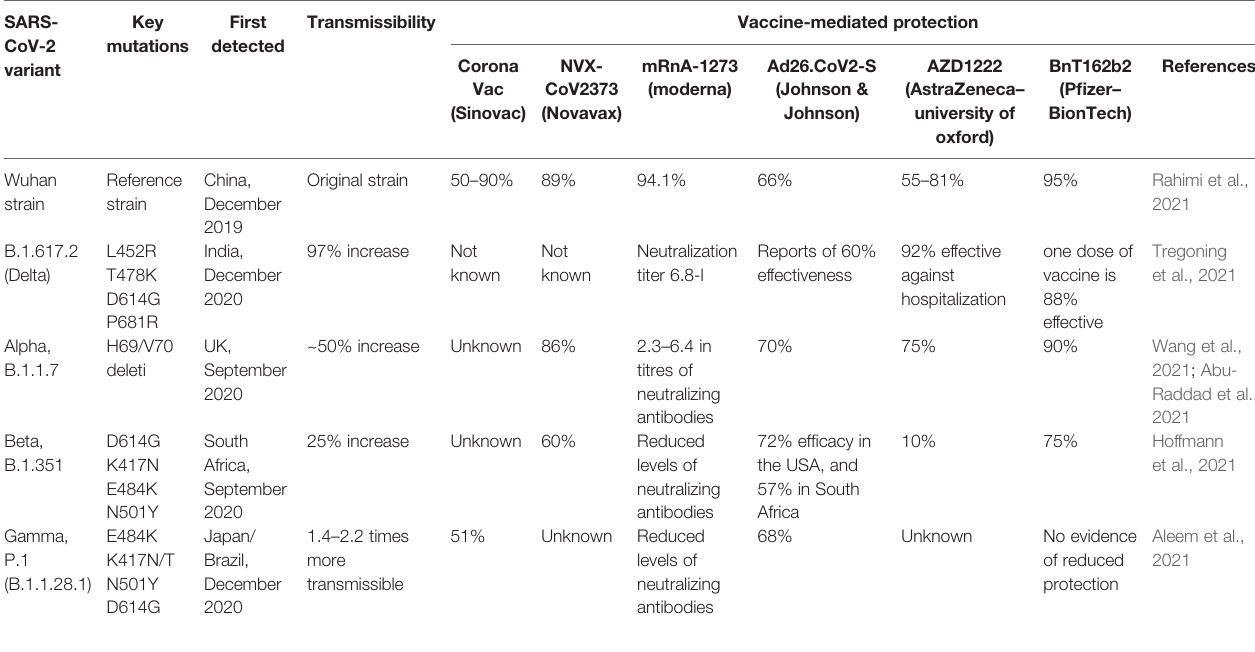
TABLE 1 | Ef fi cacy of SARS-CoV-2 vaccine on Clinical